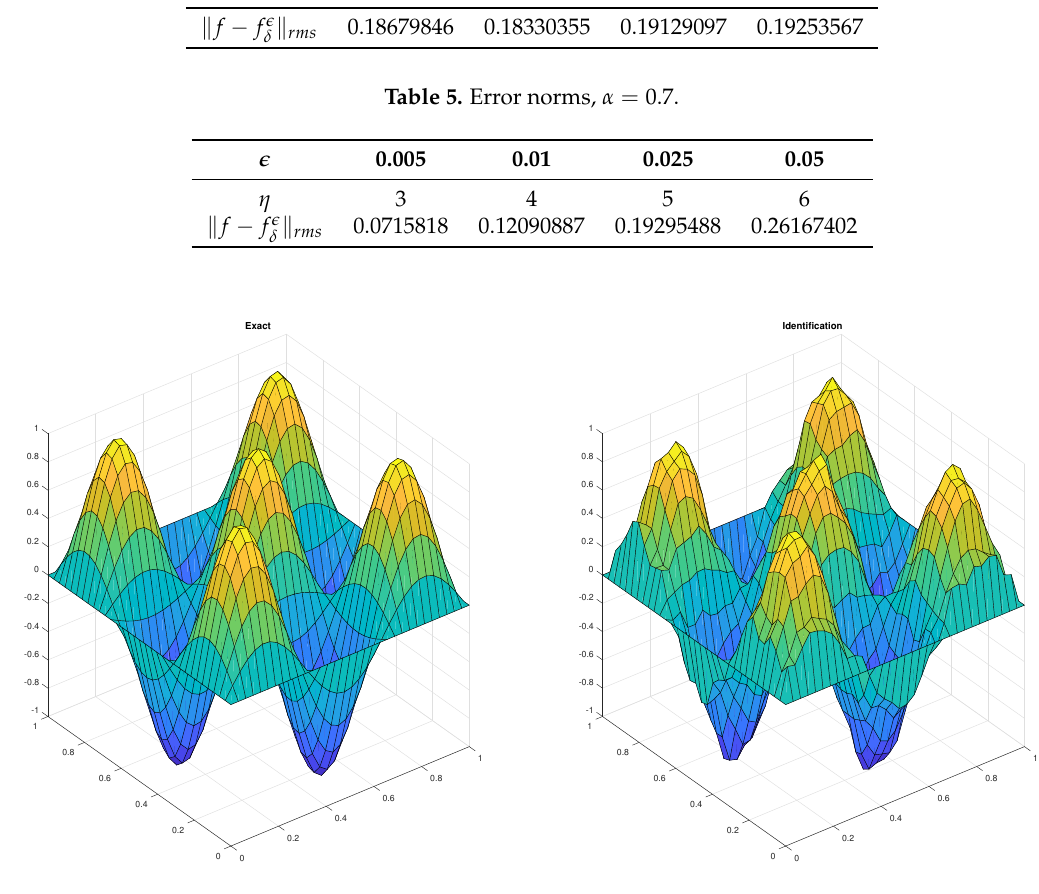
Figure 2. Identification of f for h = 1/32, (cid:101) = 0.025 and η =